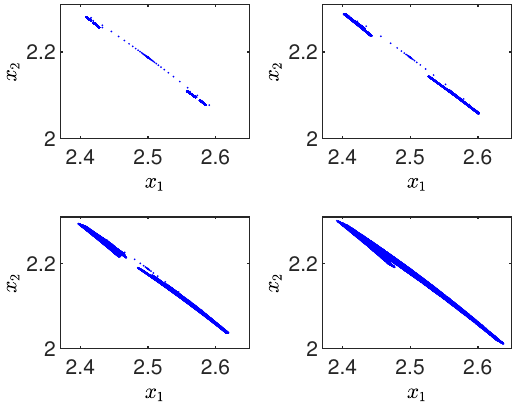
Figure 9. Birth of a chaotic attractor. Figure 10 corresponds to an extension of the chaotic attractor. Note that as a subset of the state space, the attractor A is contained, for example, in the ball centered at ( 2.5 2.15 ) T and radius 1, which means that A is bounded.